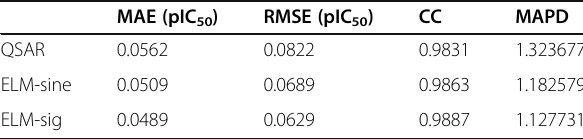
Table 9 Performance comparison of the developed QSAR